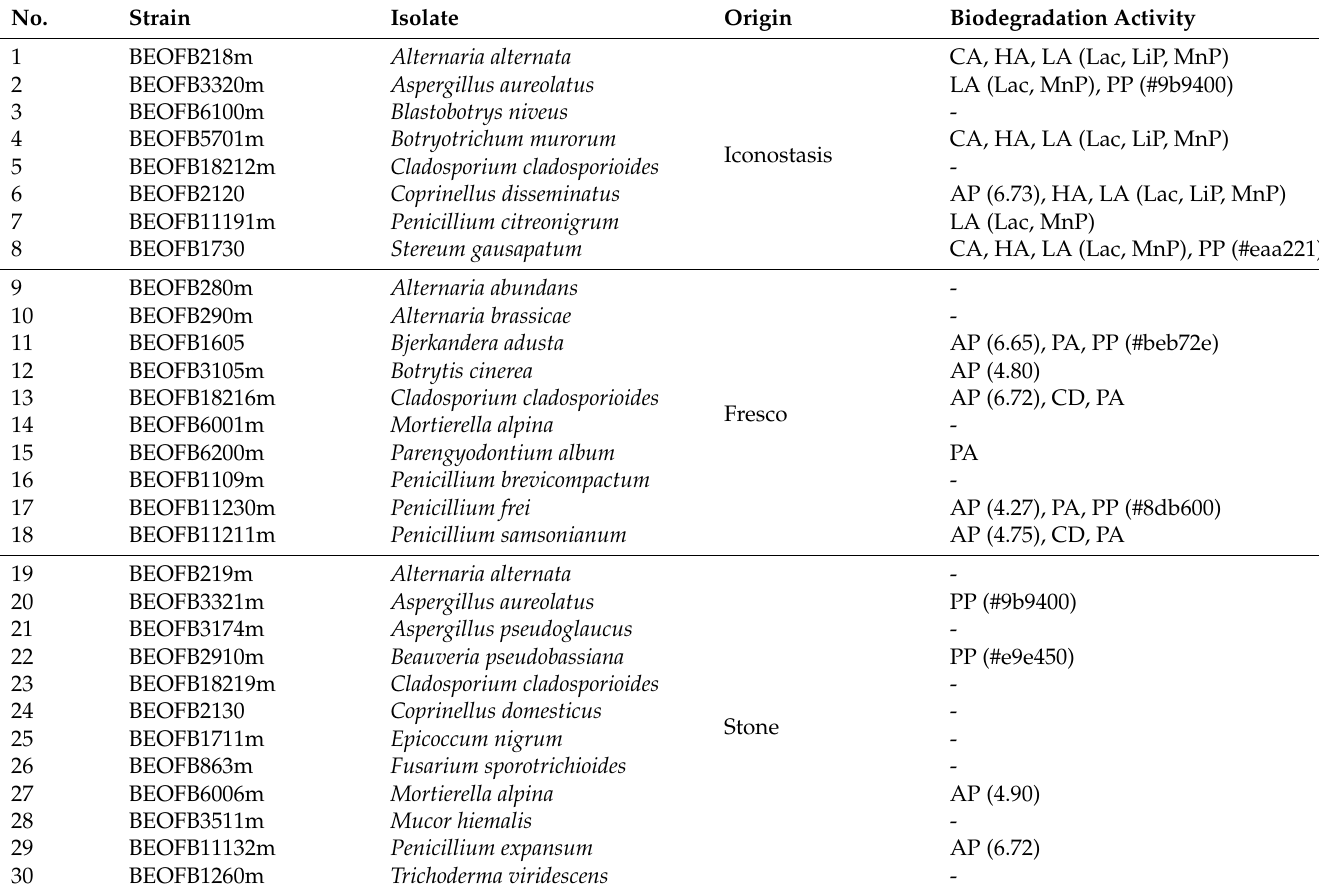
Table 2. Biodegradative profile of culturable fungi from the Cave Church of Sts. Peter and